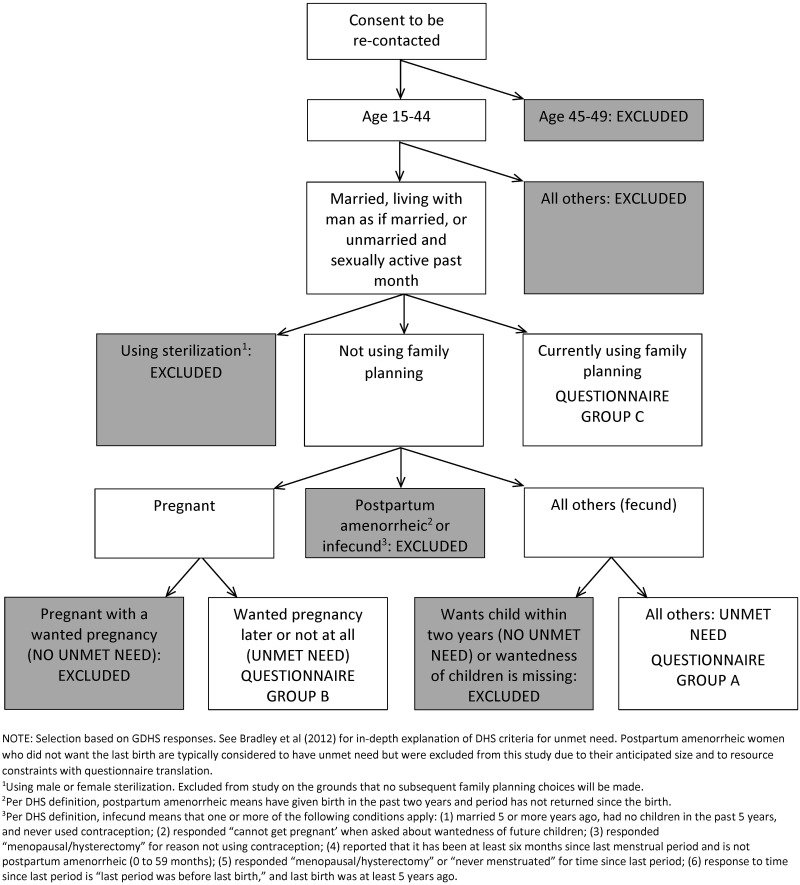
Sample selection.